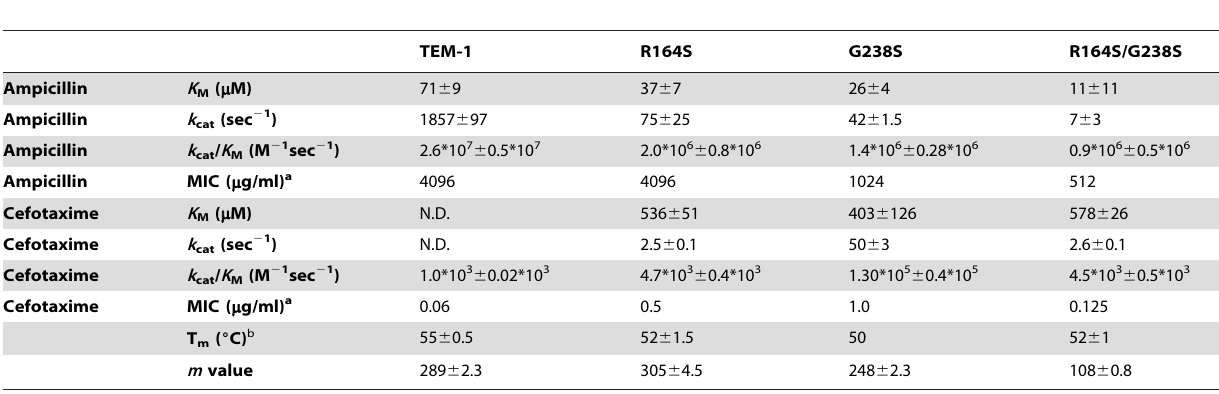
Table 1. MIC values and kinetic and stability parameters of TEM-1, single mutants R164S and G238S, and double mutant R164S/ G238S.